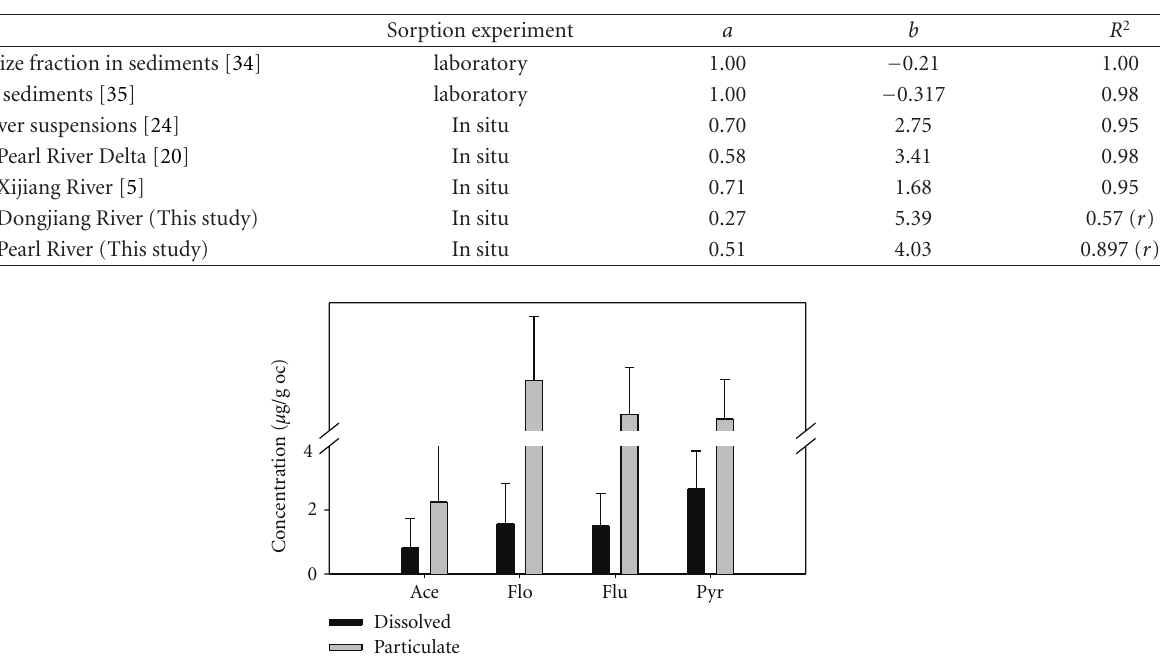
Table 4: Correlations of log K oc against log K ow values determined for selected PAHs. a , b , and R 2 correspond, respectively to slope, intercept, and square determination coe ffi cient.